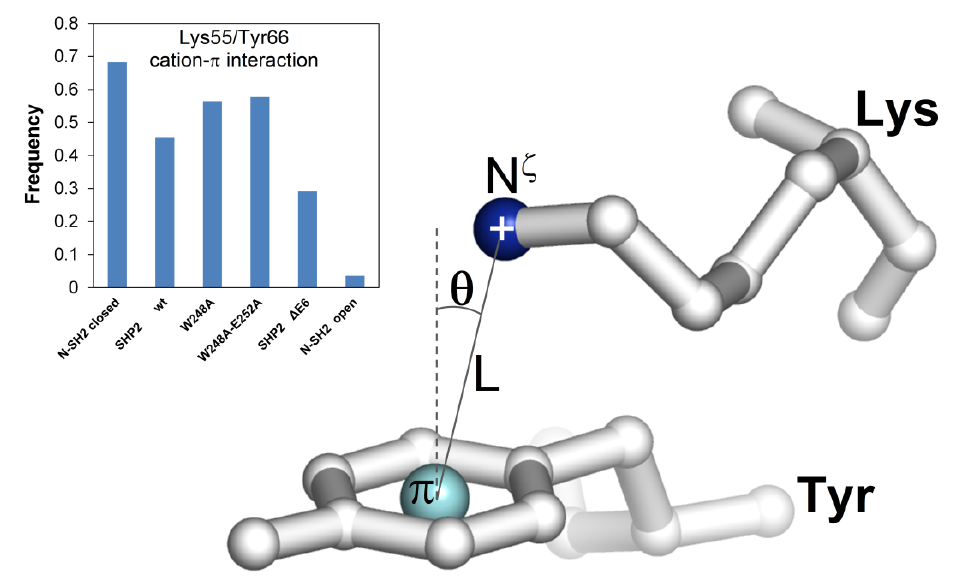
Figure 7. Fractions of MD conformers showing cation–pi interaction between Lys55 and Tyr66. The geometric conditions to identify this interaction were L ≤ 7 Å and θ ≤ 60° (see Materials and Methods for further details).